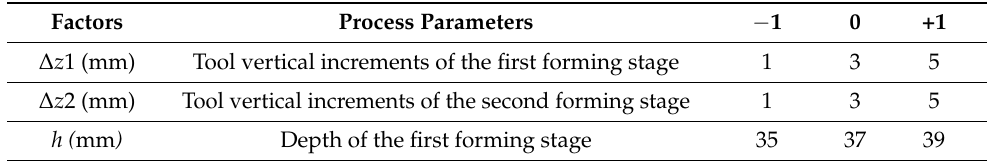
Table 1. Factors and levels used in the DoE.